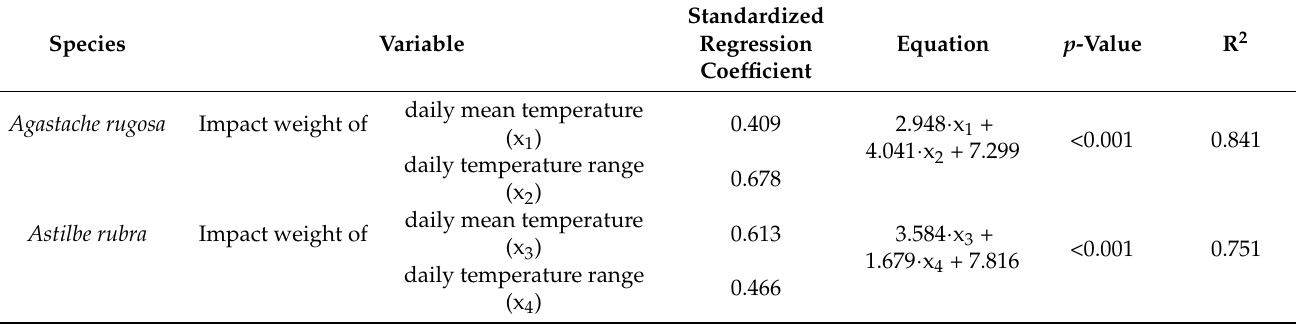
Table 2. Multiple regression analysis of the cumulative germination percentage and the cumulative impact weight of daily mean temperature (DMT) and daily temperature range (DTR) in Agastache rugosa and Astilbe rubra . The values obtained using these equations were set to a temperature score (TS) ( n =